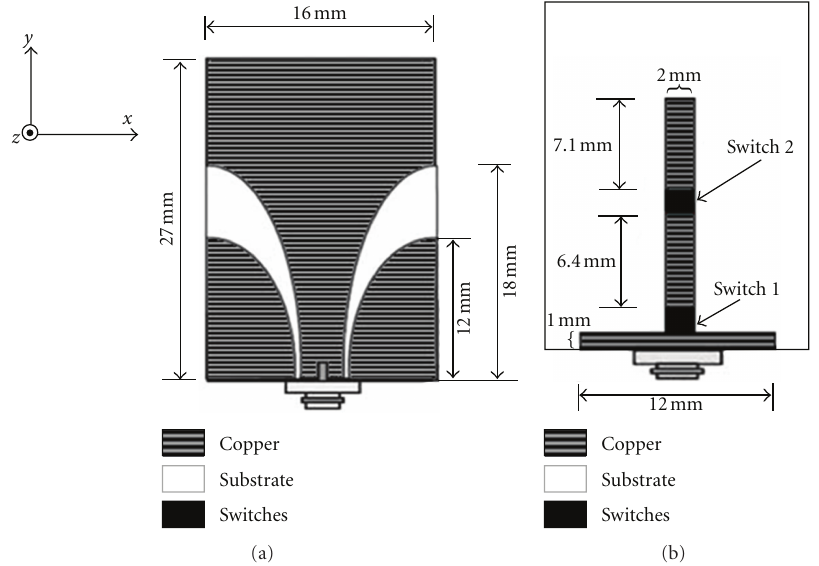
Figure 1: Geometry of the reconfigured tapered slot antenna: (a) top view, (b) bottom view.